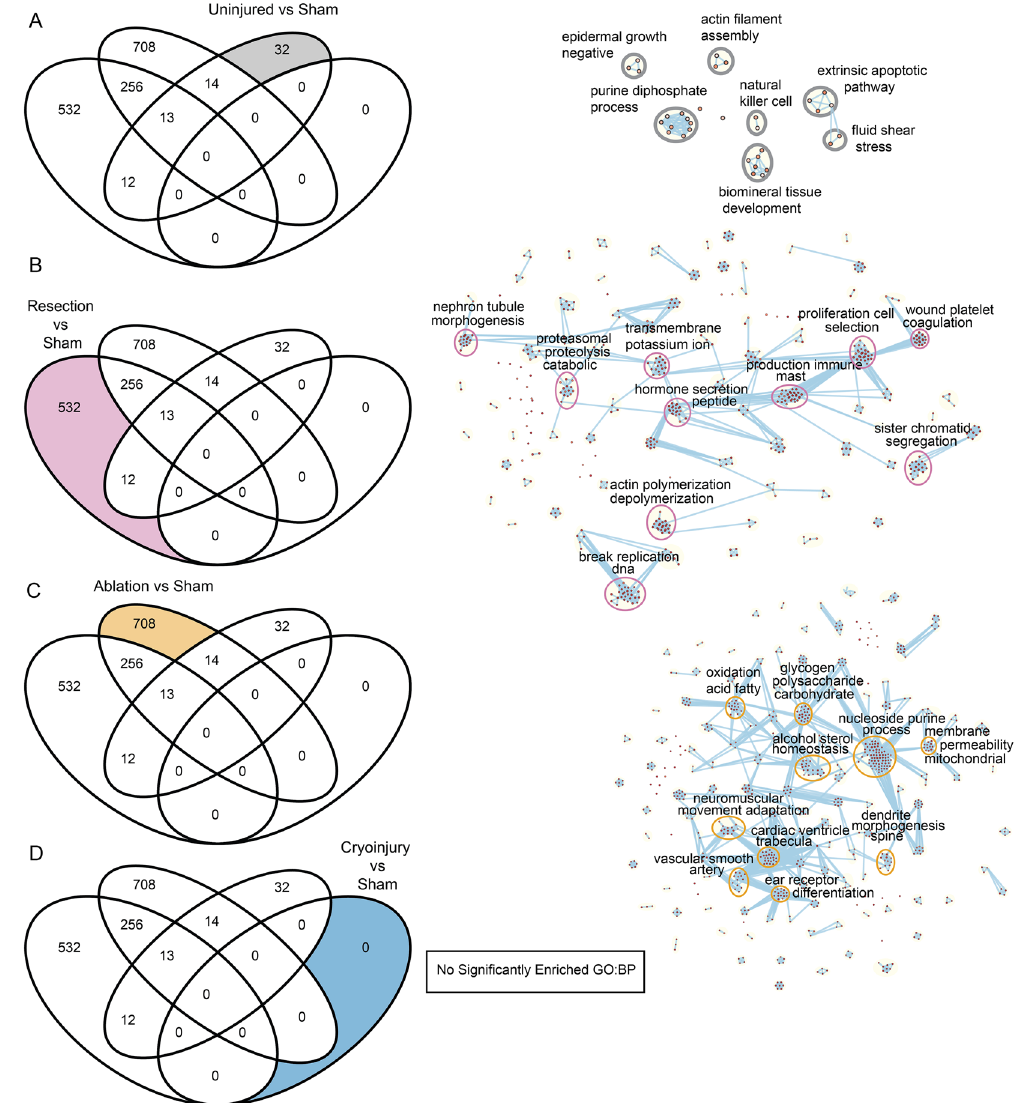
Figure 3. Biological process analysis of DEGs unique to different regeneration models. On the left, Venn diagrams of enriched Gene Ontology Biological Processes showing the specific GO:BP for each condition of interest analyzed labelled in color. On the right, Cytoscape representations of most enriched processes. Shown are data from the comparisons of the different injury models. ( A ) Uninjured vs sham, ( B ) Resection vs sham, ( C ) Ablation vs sham, ( D ) Cryoinjury vs sham, revealing no significantly enriched